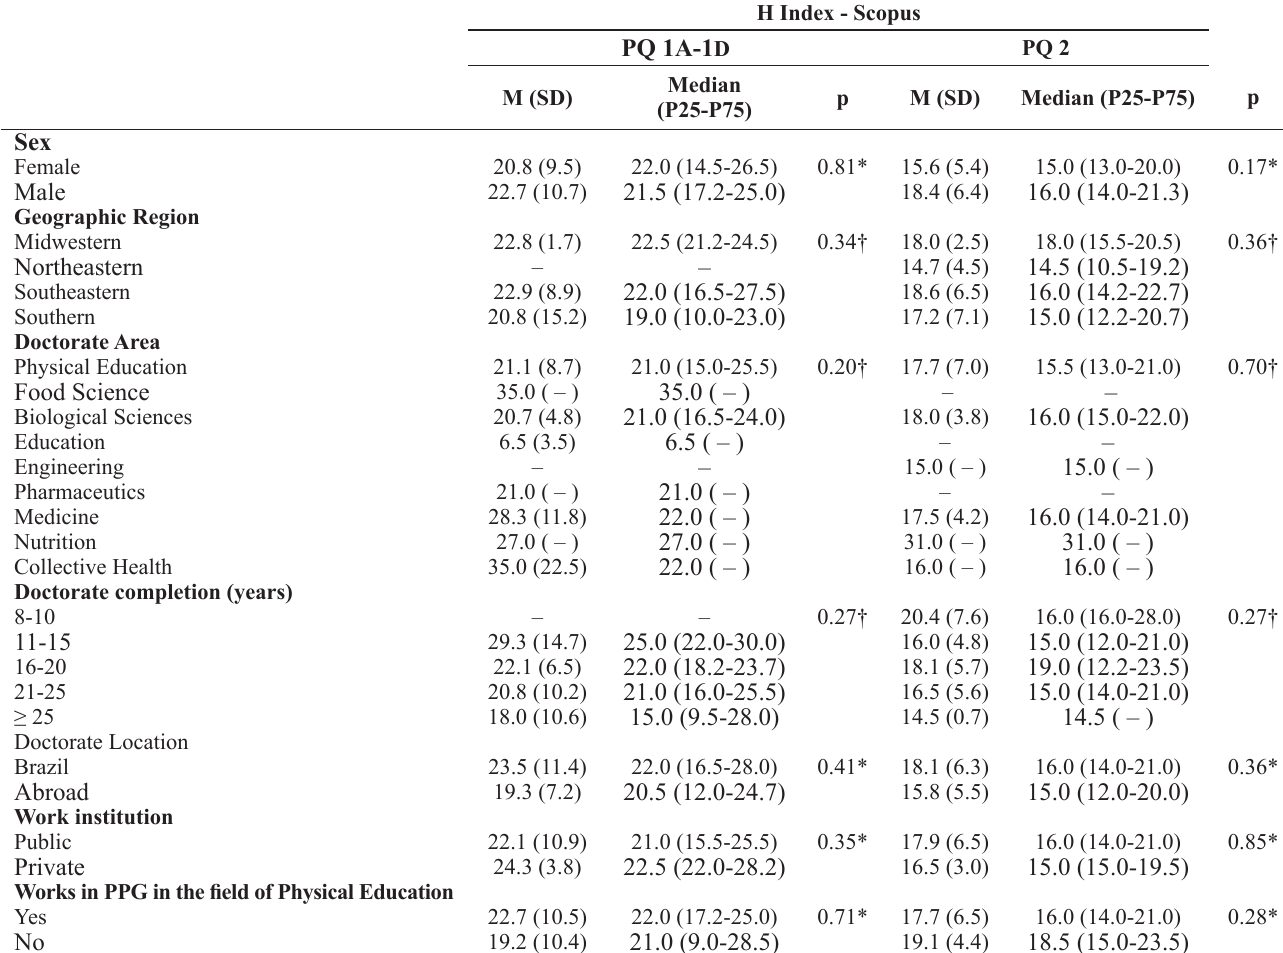
Table 3 - Comparison of the H Index according to the characterization variables for CNPq Productivity Researchers in the field of Physical Ed - ucation,